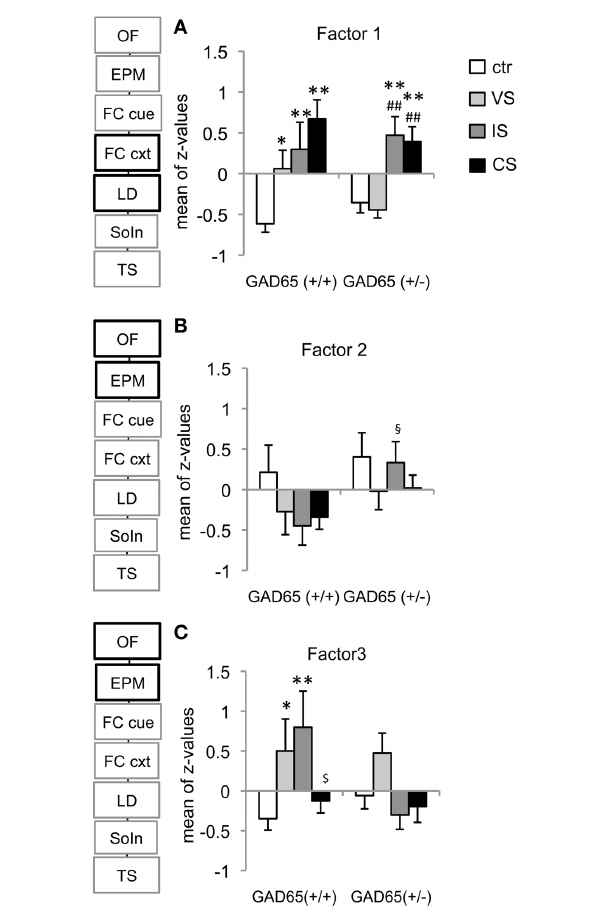
FIGURE 4 | Identified behavioral domains. (A) The strongest factor extracted “generalized fear and anxiety,” containing contextual fear memory, post-conditioning anxiety and activity was differentially affected by the genotype and stress experience. In GAD65( + / + ) mice any of the stress-protocols induced PTSD-related symptoms. Heterozygous VS-mice fully recovered from juvenile stress experience and show increased behavioral responsiveness only after IS or CS. (B) The second extracted factor “preconditioning activity” combined distance (OF) and total arm entries (EPM) and revealed a social isolation-induced reduction in activity in wild type compared to heterozygous mice. (C) The third extracted factor, “preconditioning anxiety” combined center time (OF) and % open arm entries (EPM) and confirmed the different responsiveness of GAD65( + / + ) mice to each of the stressors alone and a combination of both. ∗ p < 0 . 05, ∗∗ p < 0 . 01 compared to ctr of the same genotype, ## p < 0 . 05 compared to VS of the same genotype, § p < 0 . 05 compared to GAD65( + / + ) of the same stress group, $ p < 0 . 05 compared to IS of the same